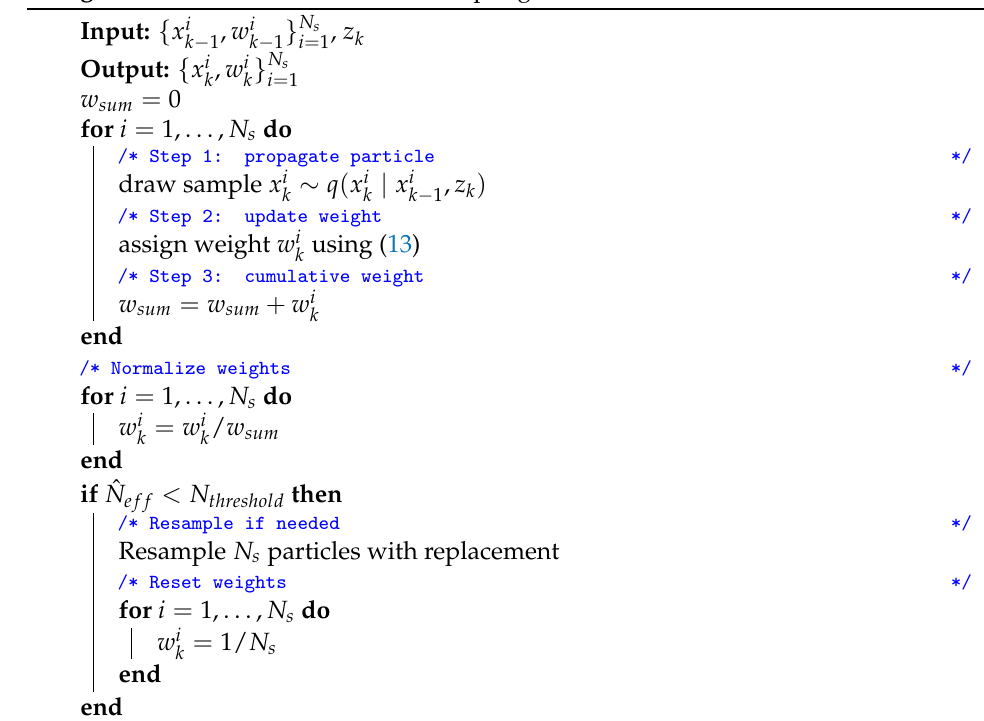
Algorithm 3: Particle filter with resampling